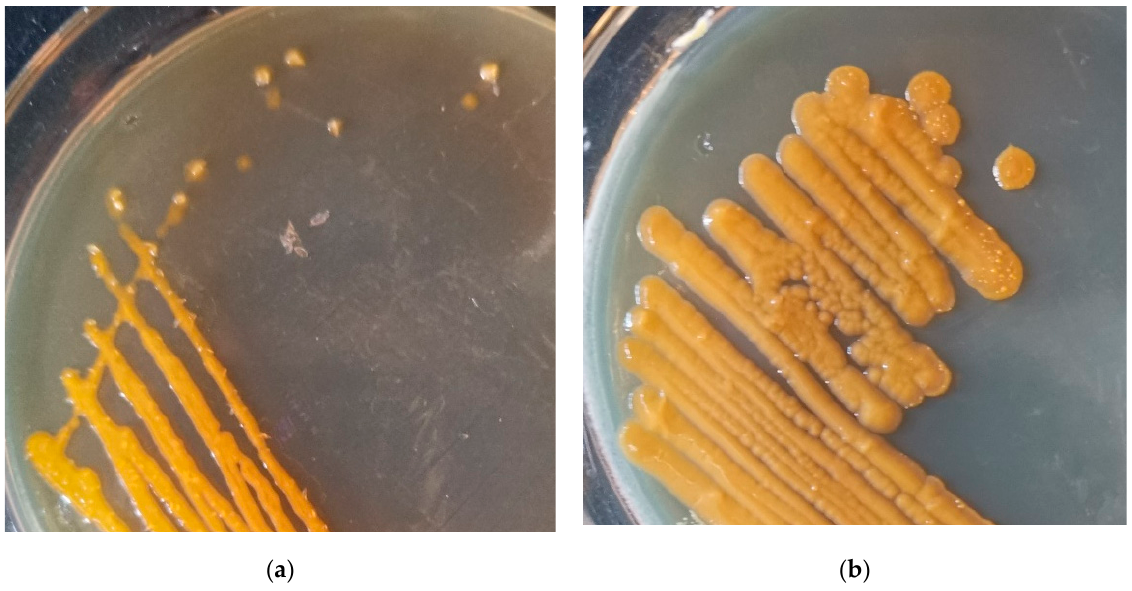
Figure 5. ( a ) The streak plate colonies of Sphingomonas morindae sp. NBD5 grown on solid medium at five day; ( b ) the streak plate colonies of Sphingopyxis sp. USTB-05 grown on solid medium at five day.